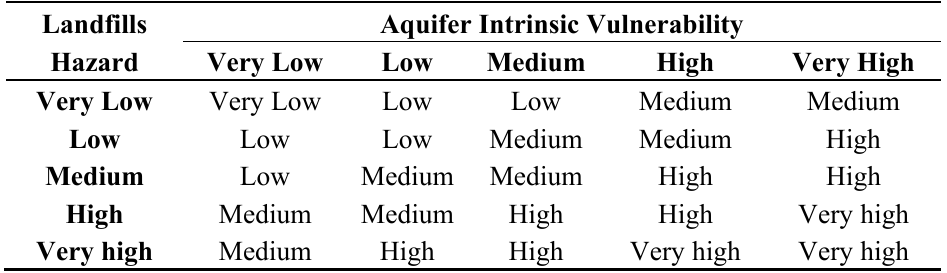
Table 3. Fuzzy rules for the evaluation of aquifer integrated vulnerability.